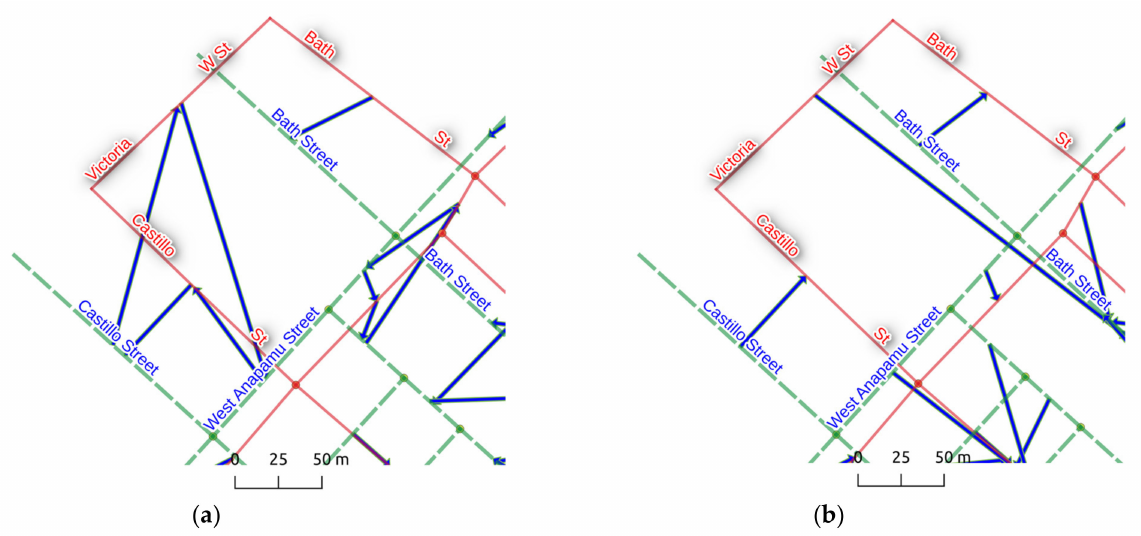
Figure 2. Transitive assignments: ( a ) transitive assignments in fc-bimatching; ( b ) removing transitive assignments with